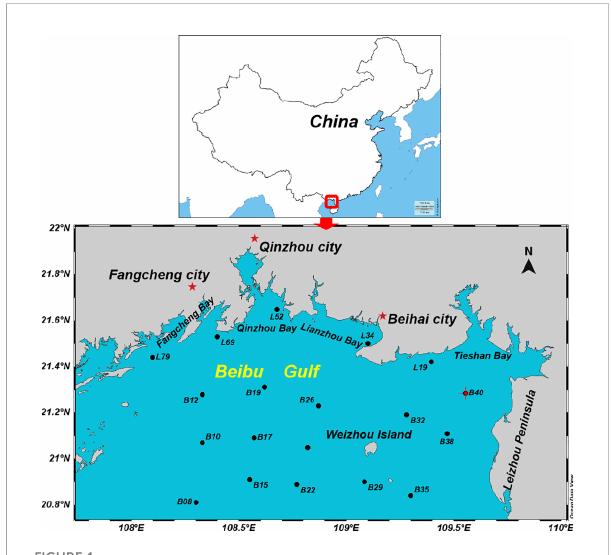
FIGURE 1 Map of the sampling sites in the Beibu